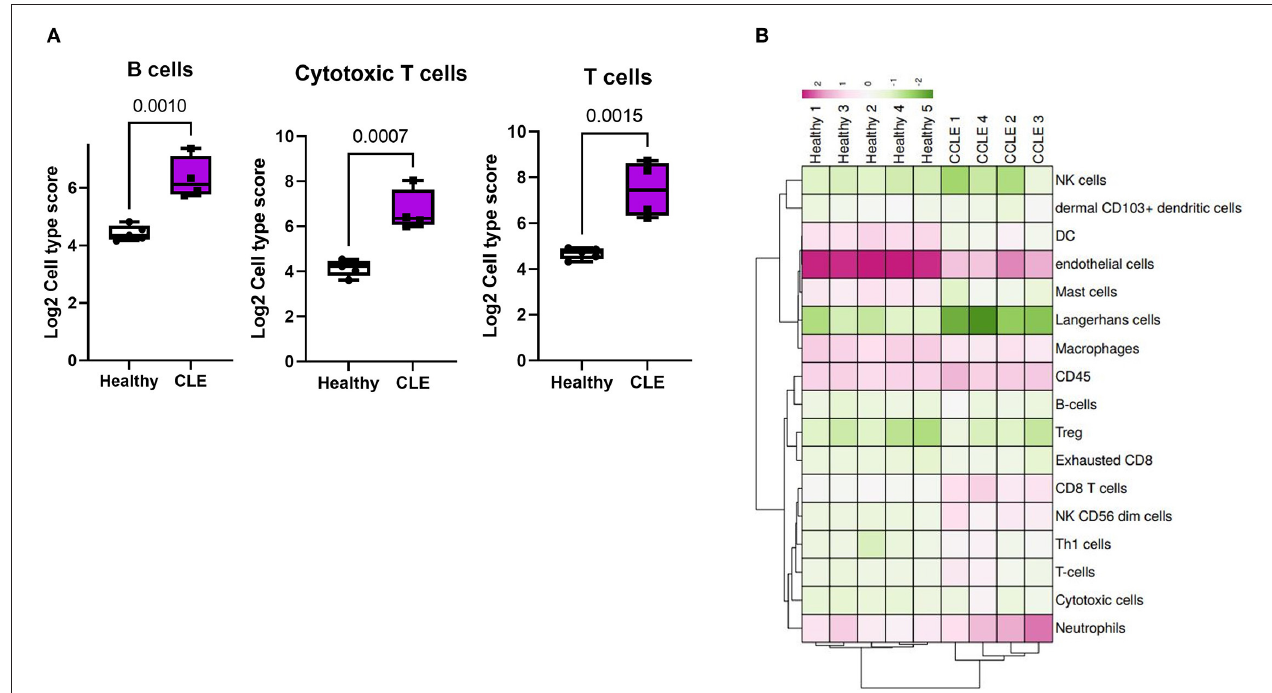
FIGURE 3 | Cell type analysis in cases vs. controls. (A) B cell, cytotoxic T cell, and T cell enrichment in cases vs. controls based on NanoString advanced cell type analysis. (B) Heatmap of all cell type signature scores.